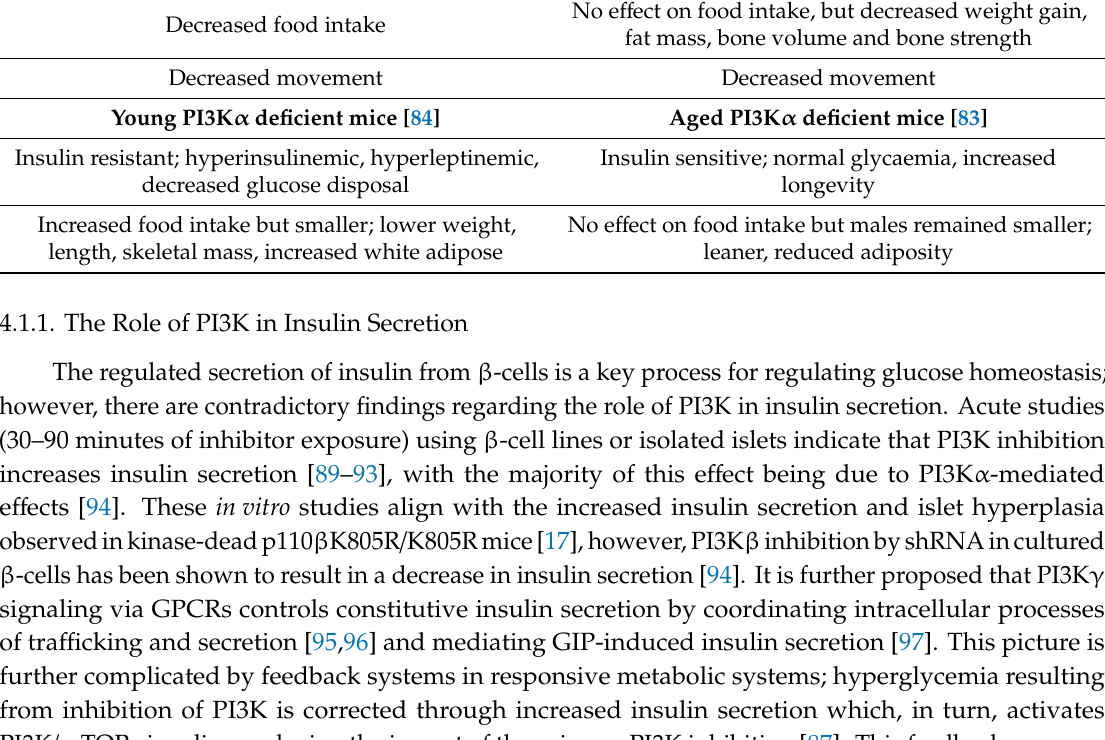
Table 3. Acute and chronic metabolic e ff ects of PI3K abrogation in a preclinical setting. Acute Administration of PI3K Inhibitors Chronic Administration of PI3K Inhibitors (Single Dose) [86] (22 Days Dosing) [85] Insulin resistant; increased gluconeogenesis, Insulin sensitive; normal gluconeogenesis, normal decreased glucose disposal glycaemia No e ff ect on food intake, but decreased weight gain, Decreased food intake fat mass, bone volume and bone strength Decreased movement Decreased movement Young PI3K α deficient mice [84] Aged PI3K α deficient mice [83] Insulin resistant; hyperinsulinemic, hyperleptinemic, Insulin sensitive; normal glycaemia, increased decreased glucose disposal longevity Increased food intake but smaller; lower weight, length, skeletal mass, increased white